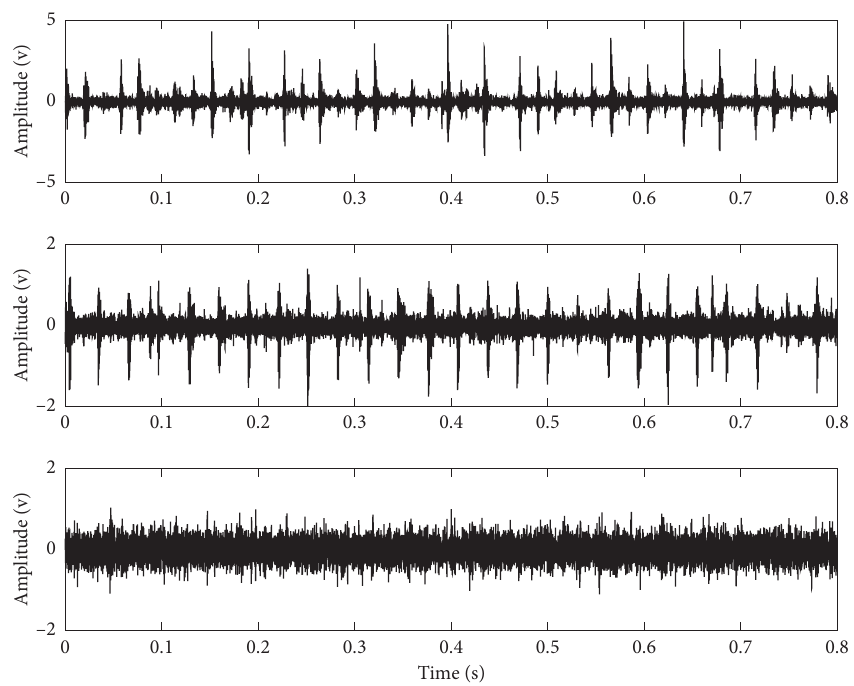
Figure 10: The 3 separated components [ S ″